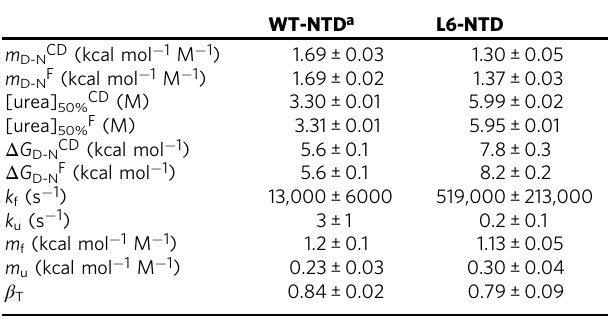
β T denotes the Tanford β -value, calculated from m f and m u (ref. 17 ). Errors of β T are propagated s.e. from regression analysis a Equilibrium thermodynamic quantities are from ref. 17 ; kinetic quantities are from ref. 11 . Errors are s.e. from regression